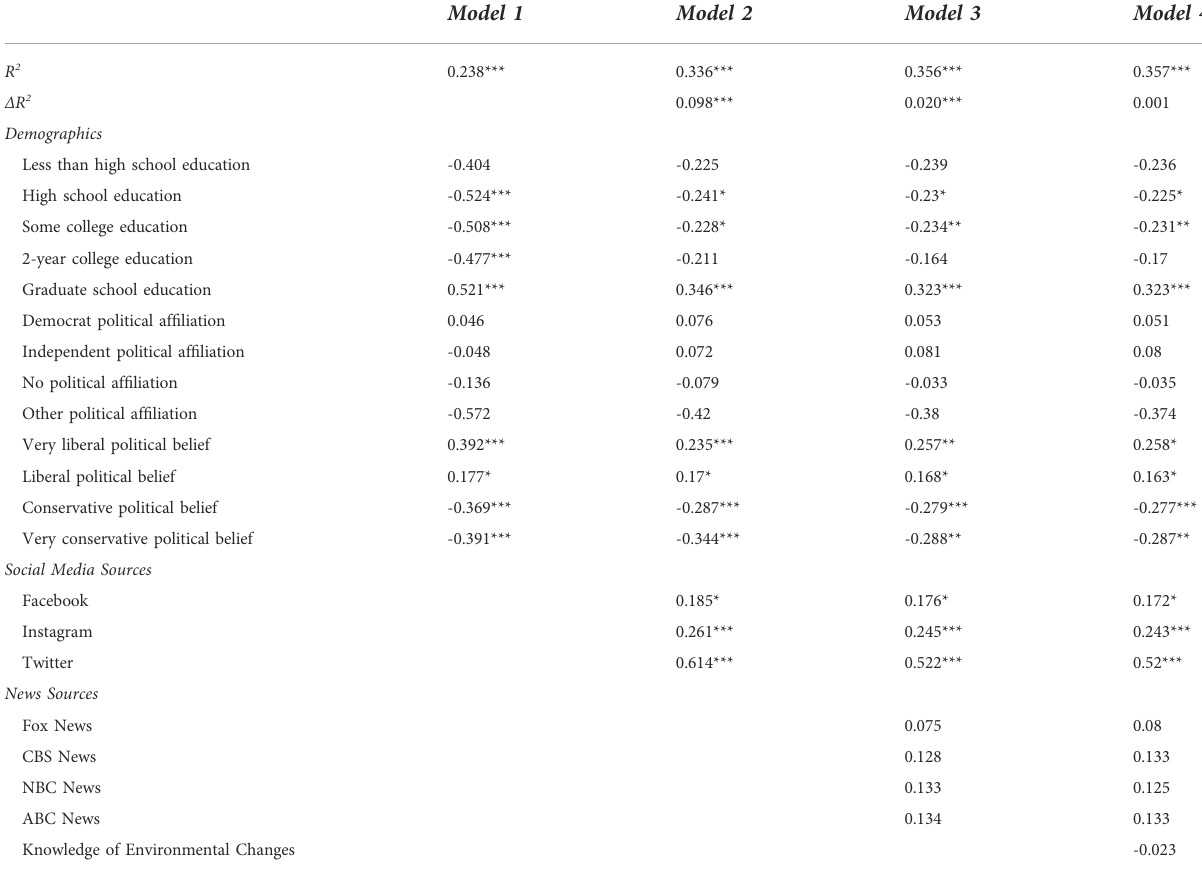
TABLE 6 Predicting the likelihood of intent to engage in future environmentally-conscious behavior using Demographics, Social Media Use, News Media, and Knowledge of Environmental Changes (N =